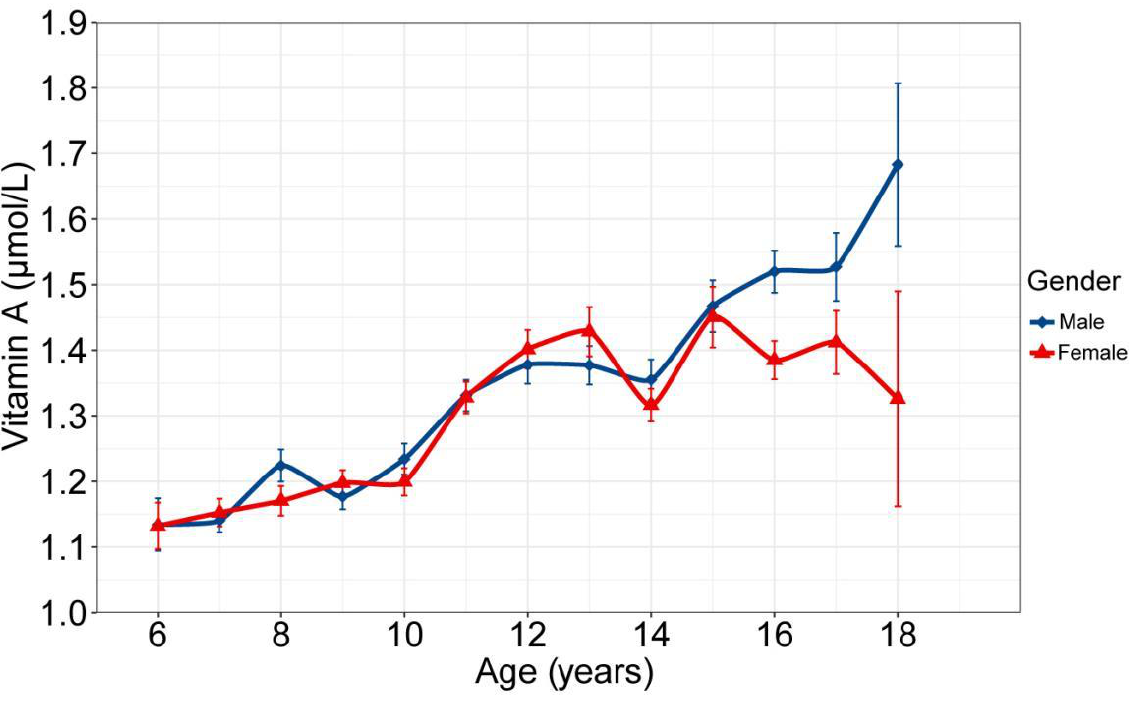
Figure 1. Change in vitamin A with age for different sexes. Means and standard error of the means are shown.